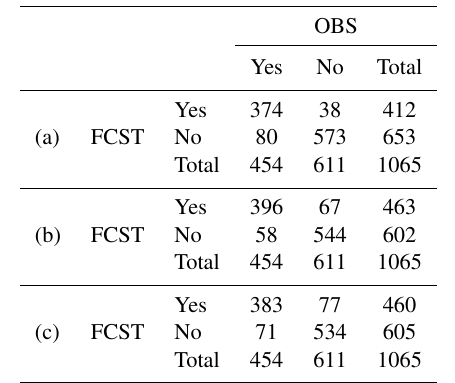
Table 1. Contingency tables based on the rule that regime change will occur in the orbit following the appearance of high-growth-rate bred vectors using three different methods. In (b) and (c) using the nearest-neighbor breeding, high-growth-rate points in orbits with absolute values of extrema above 1 are excluded. OBS and FCST stand for observed and forecast, respectively; (a)–(c) are the same as in Fig. 1.